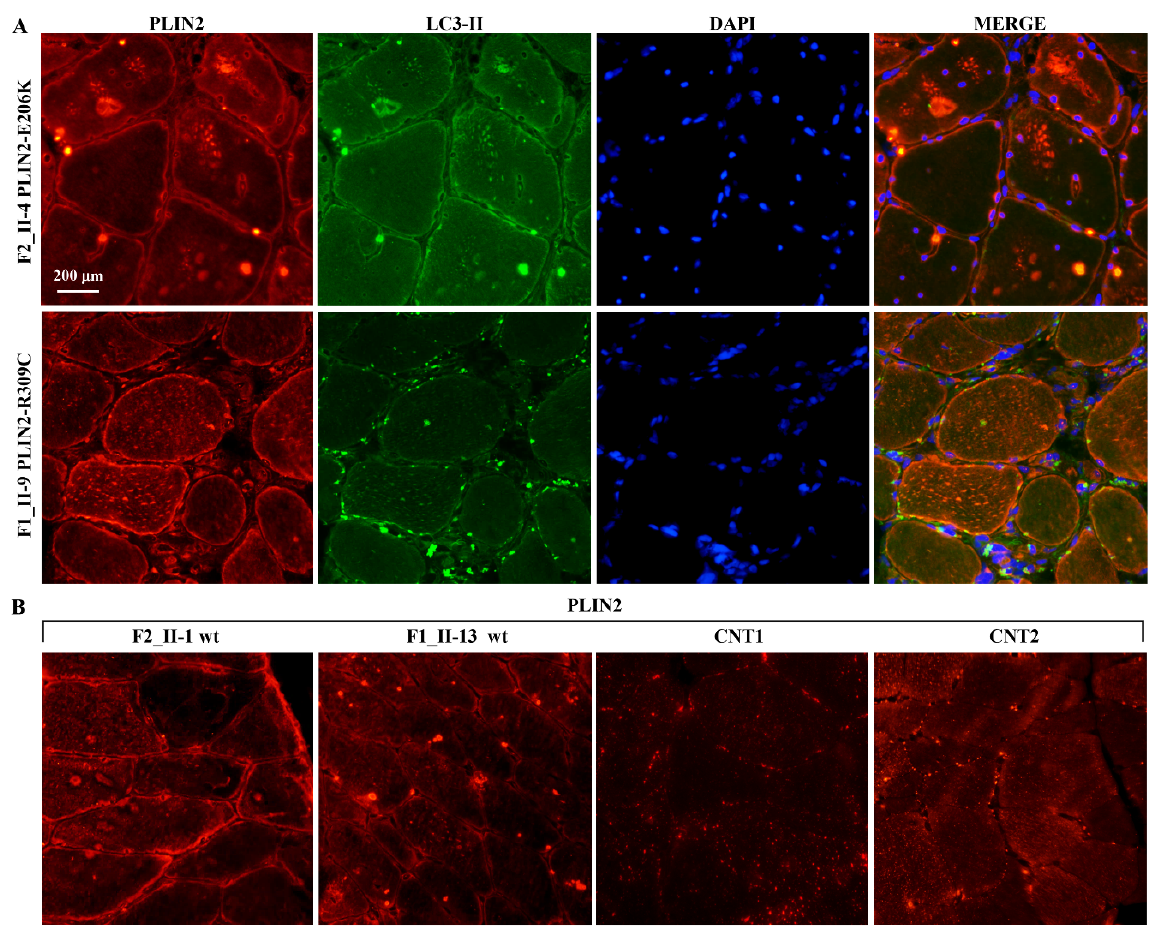
Figure 8. PLIN2 and LC3 immuno-localization on skeletal muscle tissues. ( A , B ) Continuous PLIN2/CY3 signal with variable intensity delineated the sarcolemma in mutated ( A ) and wild type ( B ) muscle fibres, while it appears faint and discontinuous in external controls (CNT1, CNT2). PLIN2/CY3 immunofluorescence marked numerous sarcoplasmic macro- and micro-vacuoles in the mutated muscles ( A ), which were less numerous in both wild type biopsies ( B ). External controls disclosed fine and scattered sarcoplasmic spots of PLIN2 positivity. Spots of LC3/FITC immunofluorescence were visible along the sarcolemma membranes and in overlap with only a few PLIN2-positive spots in mutated tissues ( A ). Nuclei were counterstained with DAPI (blue). Scale bar: 200 μ m.